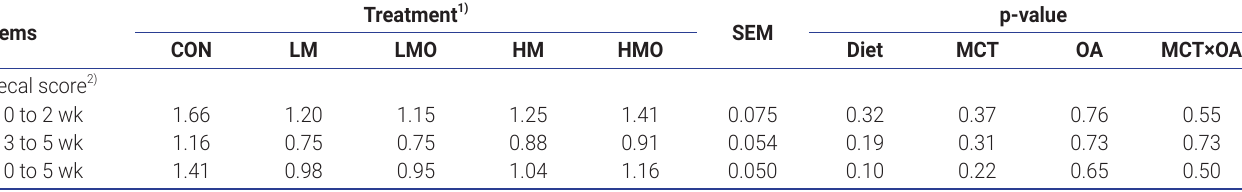
Table 4. Effects of medium chain triglycerides and organic acids on the fecal score in weaning pigs Treatment 1) Items